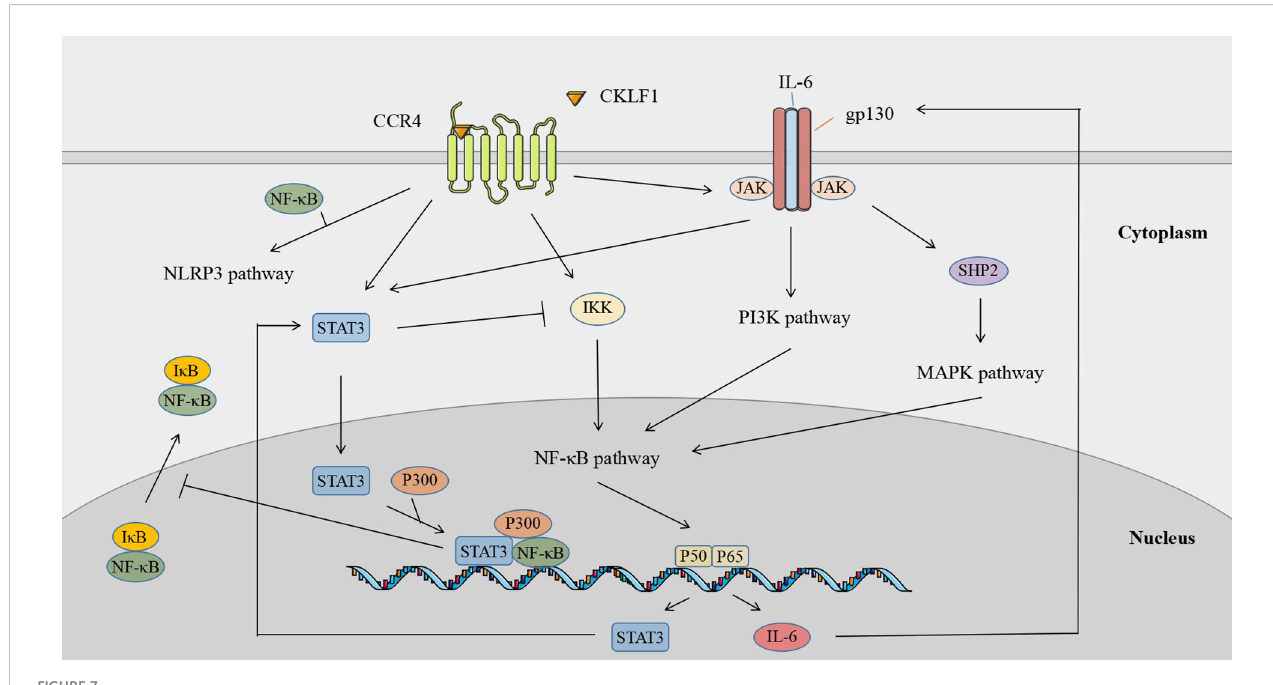
FIGURE 7 Signaling crosstalk across downstream pathways of CKLF1.